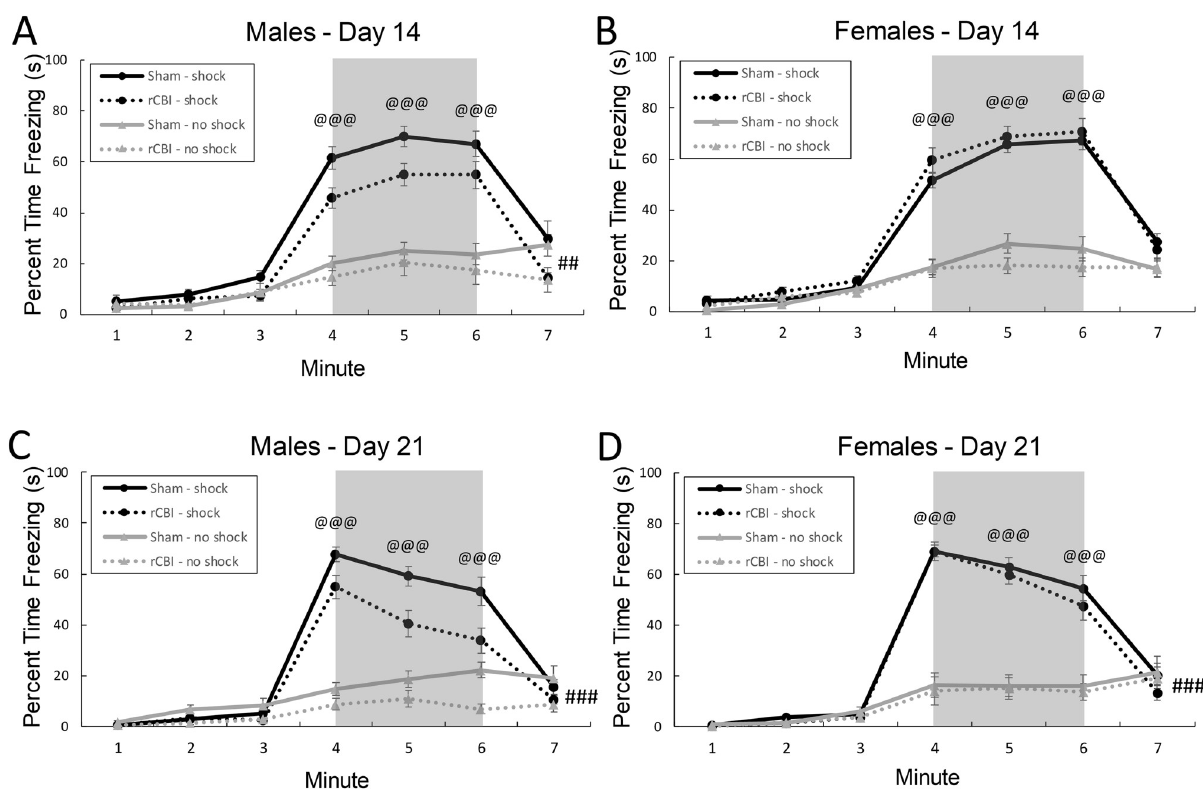
Fig 9. Freezing behavior during a cue test (with the tone presented during minutes 4–6, regions shaded in gray) on days 14 (A & B) and 21 (C & D) following rCBI (days 7 and 14 following tone/shock association. Shock status had a significant effect on amount of freezing behavior during the minutes in which the tone was presented (4–6; @@@, Shock > No Shock, p < 0.0001), on both days 14 and 20 following rCBI (A-D). On day 14, there was an effect of rCBI in male mice ( A ), with injured mice displaying less freezing behavior than sham controls during the test session (##, Male rCBI < Male Sham, p < 0.01). On day 21, there was a main effect of rCBI, with all injured mice freezing less during the test session than sham controls (###, Sham > rCBI, p = 0.0001). rCBI, repetitive concussive brain injury.